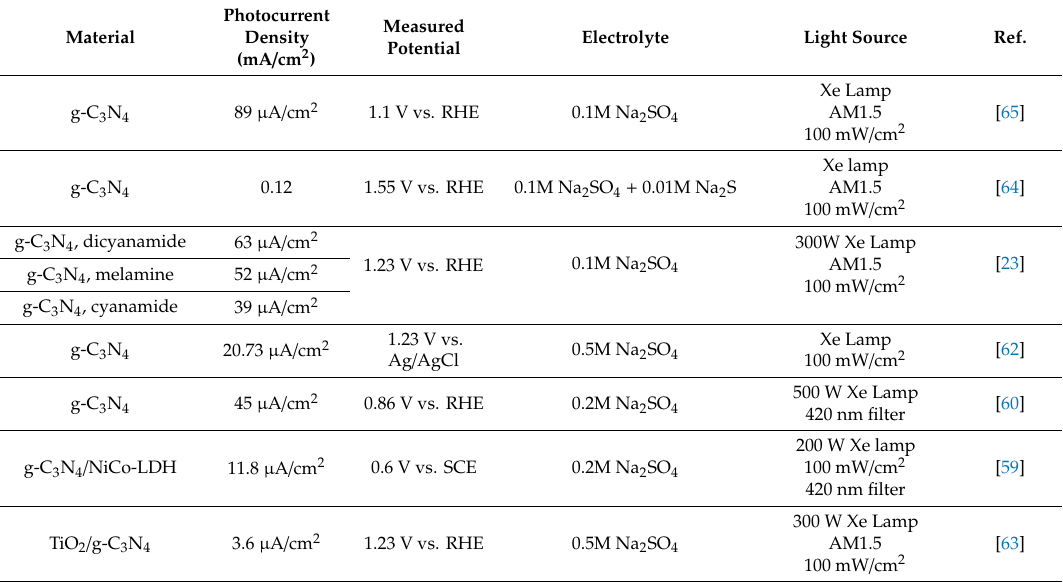
Table 4. Carbon-based materials for photoelectrochemical